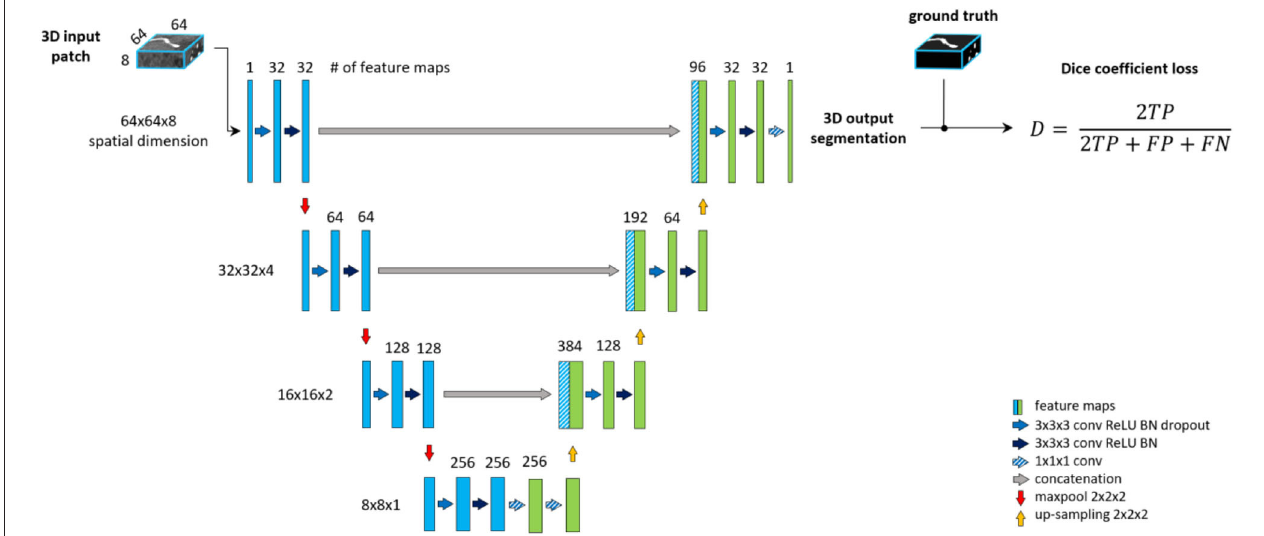
FIGURE 2 | The baseline architecture. A standard Unet architecture, coined Unet , consisting of four levels, two consecutive sequences of convolution, ReLU, Batch-normalization at each level of encoding (left side) and decoding (right side) part. Two additional fully connected layers are added to the last level realized by 1 × 1 × 1